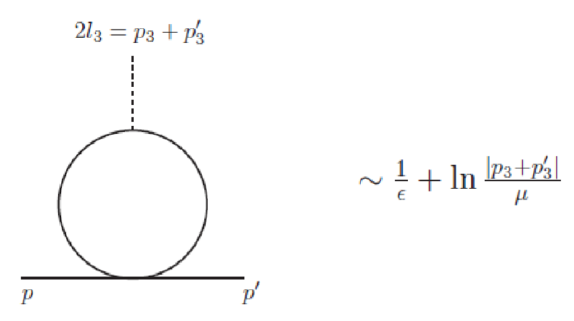
Figure 2 . A boundary contribution to the scalar two-point function with (cid:30) 4